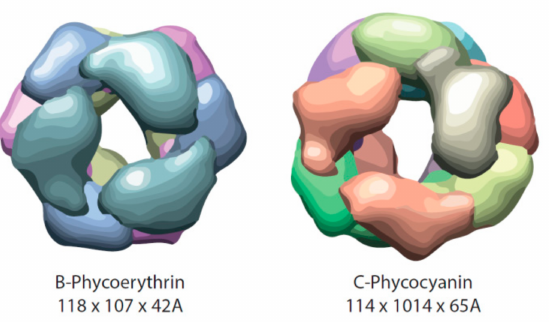
Figure 1. 3D structure for the biliproteins used in this work: C-Phycocyanin and B-phycoerythrin in the hexameric state.